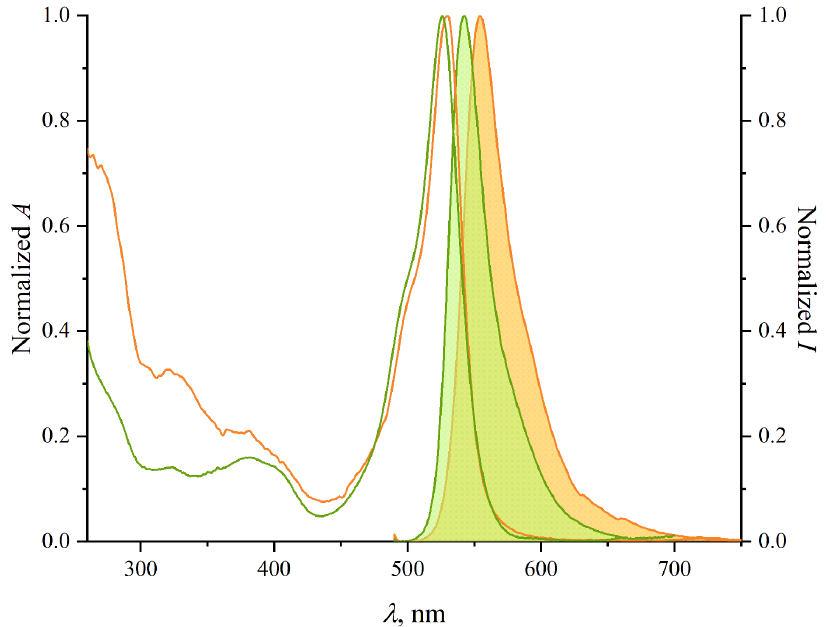
Figure 6. Absorption (unfilled area plot) and emission (filled area plot) spectra of NHS-Ph-BODIPY (green) and BSA–NHS-Ph-BODIPY (orange) in a DMSO–bicarbonate buffer (pH 8.3) mixture (1:9). Table 4. Photophysical characteristics of NHS-Ph-BODIPY and BSA – NHS-Ph-BODIPY in a DMSO – bicarbonate buffer (pH 8.3) mixture (1:9).